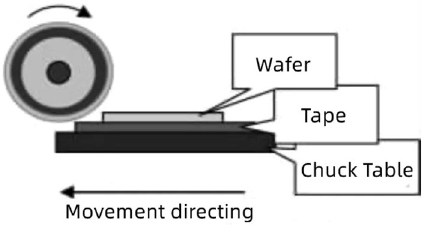
Fig. 3 Schematic diagram of scribing and cutting